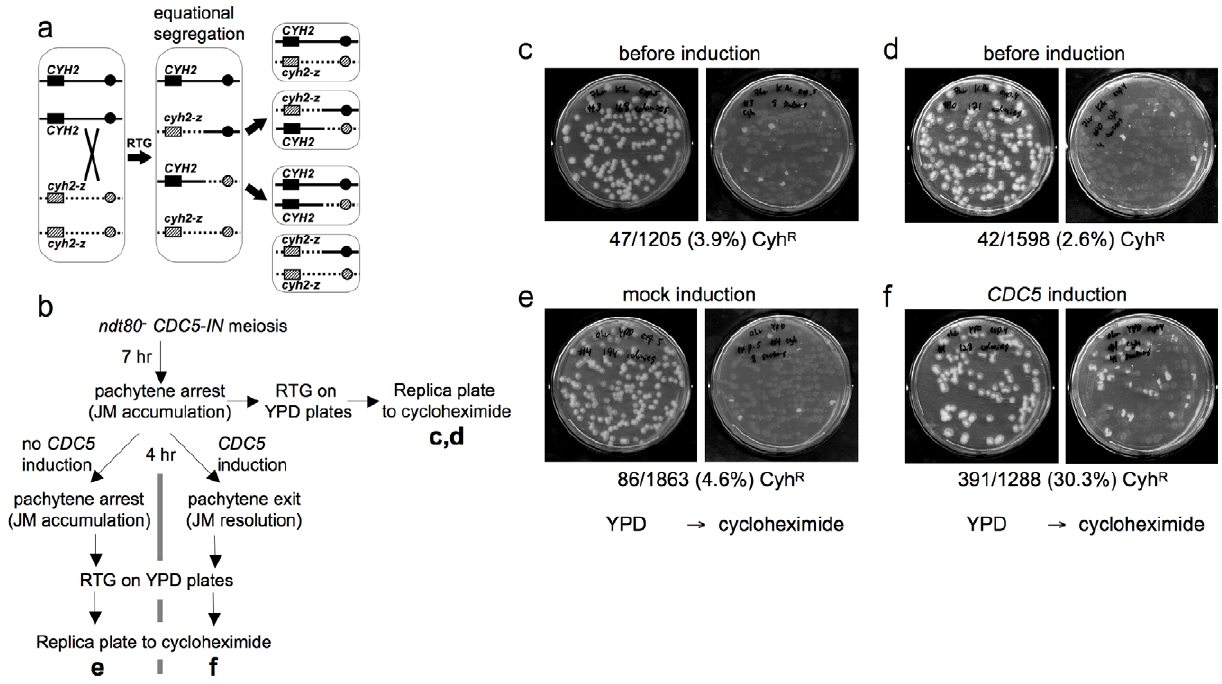
Figure 3. Few COs are produced after RTG. a. CO detection after RTG. Chromosome VII homologs are shown as solid and dashed lines. Black and grey boxes indicate dominant CYH2 and recessive cyh2-z cycloheximide sensitive and resistant alleles, respectively. If a CO occurs between CYH2 and the centromere, equational chromosome segregation produces either a colony that is uniformly CYH2/cyh2-z (cycloheximide-sensitive), or a colony with a CYH2/CYH2 (cycloheximide-sensitive) sector and a cyh2-z/cyh2-z (cycloheximide-resistant) sector. b. Experimental design. ndt80 D CDC5-IN (MJL3267) cells are incubated in sporulation medium for 7 hr to uniform pachytene arrest, and aliquots are plated on YPD for RTG (c and d). The culture is then incubated for an additional 4 hr without CDC5 induction and plated on YPD (e), or the culture is incubated for 4hr in the presence of estradiol to induce CDC5 expression before plating on YPD (f). Colonies on YPD are replica-plated to YPD + cycloheximide to detect cyh2-z/cyh2-z recombinants. c, d. Control aliquots plated directly on YPD before replica-plating to YPD + cycloheximide. e. Pachytene-arrested cells were incubated for 4 hr without CDC5 induction before plating on YPD. f. Pachytene-arrested cells were incubated for 4 hr with estradiol to induce CDC5 expression before plating on YPD. Note the marked increase in the frequency of cycloheximide-resistant